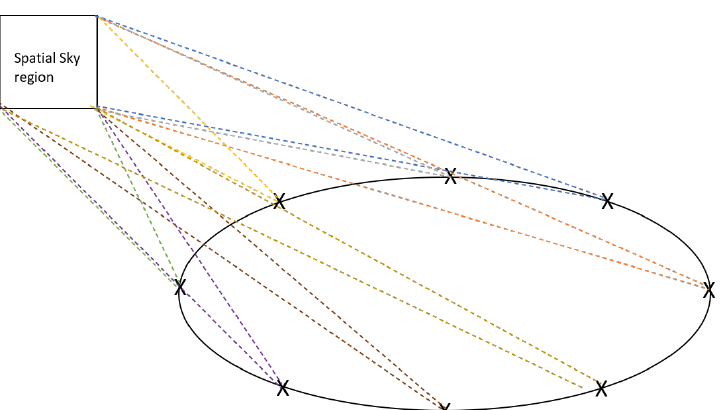
Figure 5. A diagram of satellite constellations observing the same spatial region in order to capture a microlensing parallax of any microlensing event occurring the given field-of-view. X represents a satellite with a CS detector system.